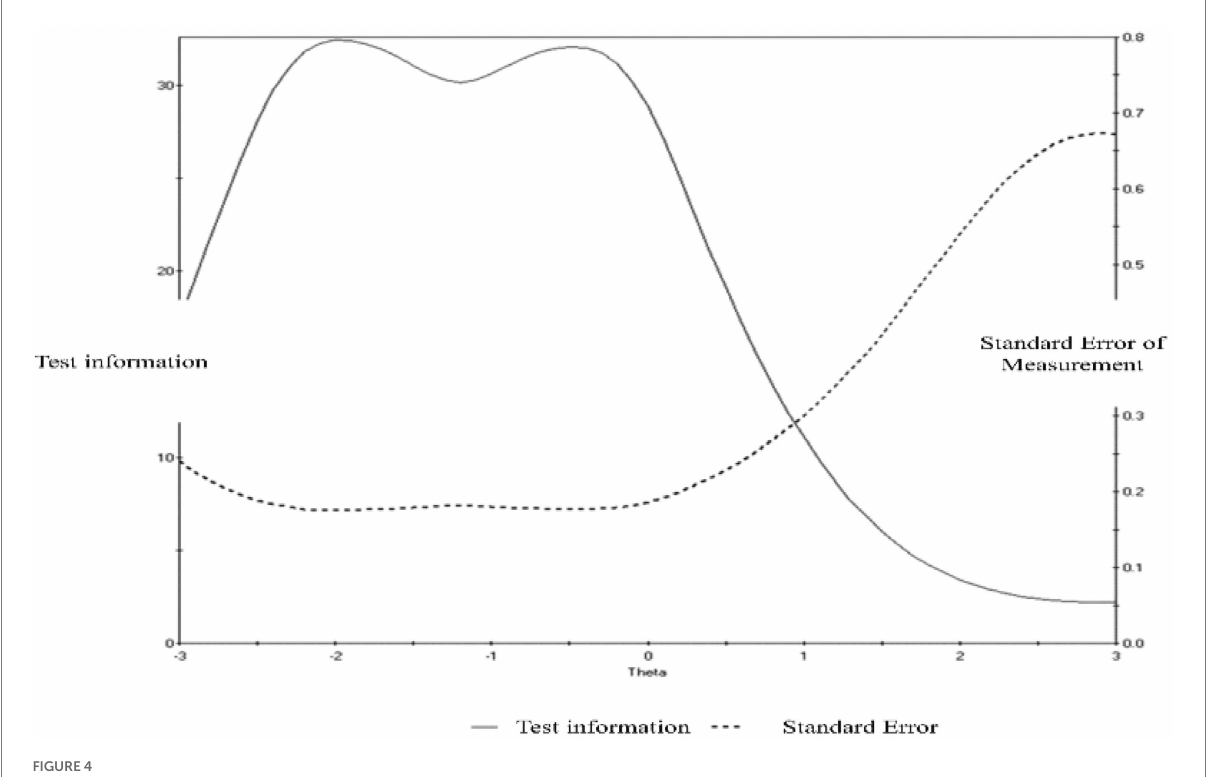
FIGURE 4 Test information and standard error of measurement of the